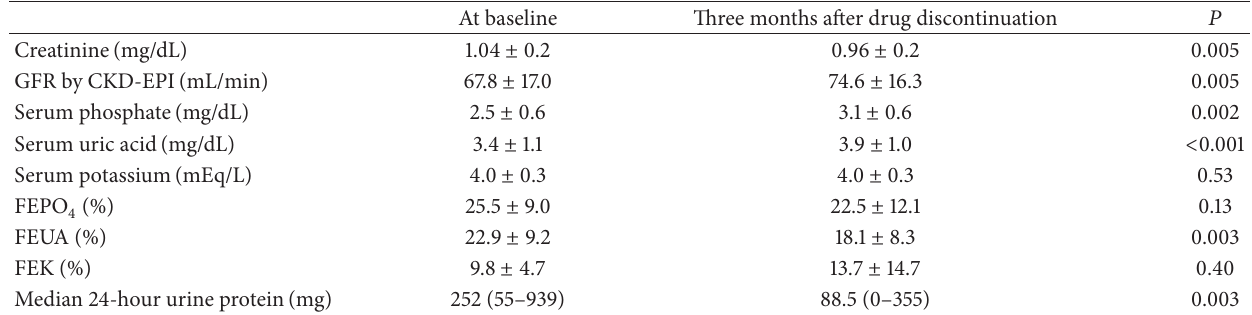
Table 3: Blood and urine chemistries at baseline and 3 months after discontinuation of nucleotide analogues in 17 patients with proximal renal tubular dysfunction (RTD).